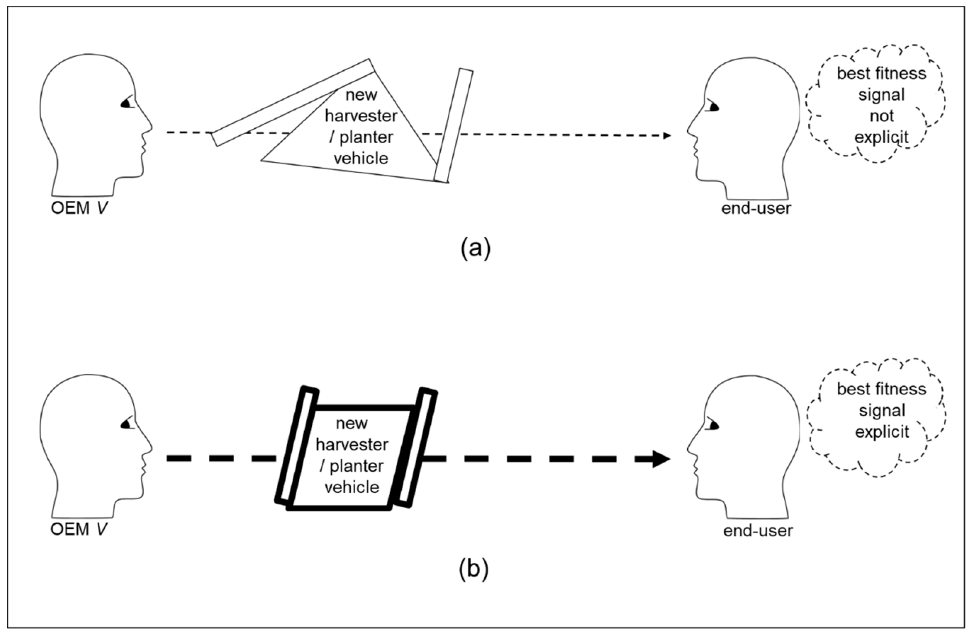
Figure 5. Risk and ambiguity. ( a ) The end-user assesses the risk to be higher because the end-user has many inferential steps due to the OEM developing a new harvester/planter vehicle that is not symmetrical and does not have the easily recognizable features of the OEM’s previous product vehicles. ( b ) The end-user assesses the risk to be low because the end-user has fewer inferential steps due to the OEM developing a new harvester-planter vehicle that is symmetrical and does have easily recognizable features of the OEM’s previous product vehicles.